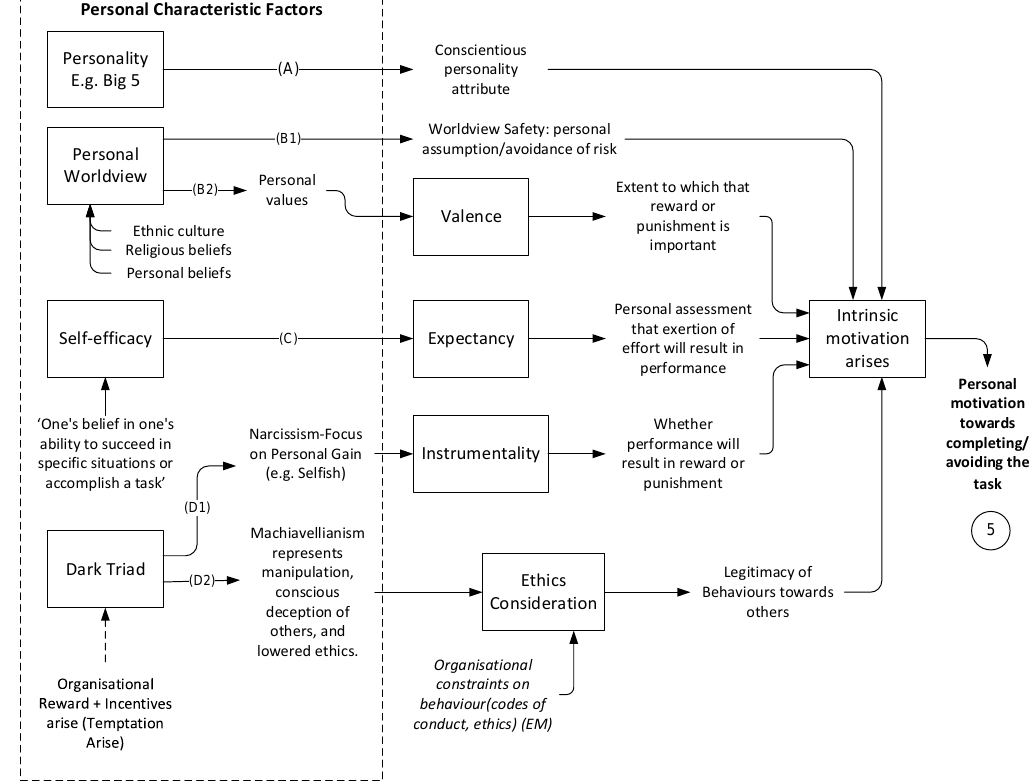
Figure 5. Intrinsic Motivation Model.